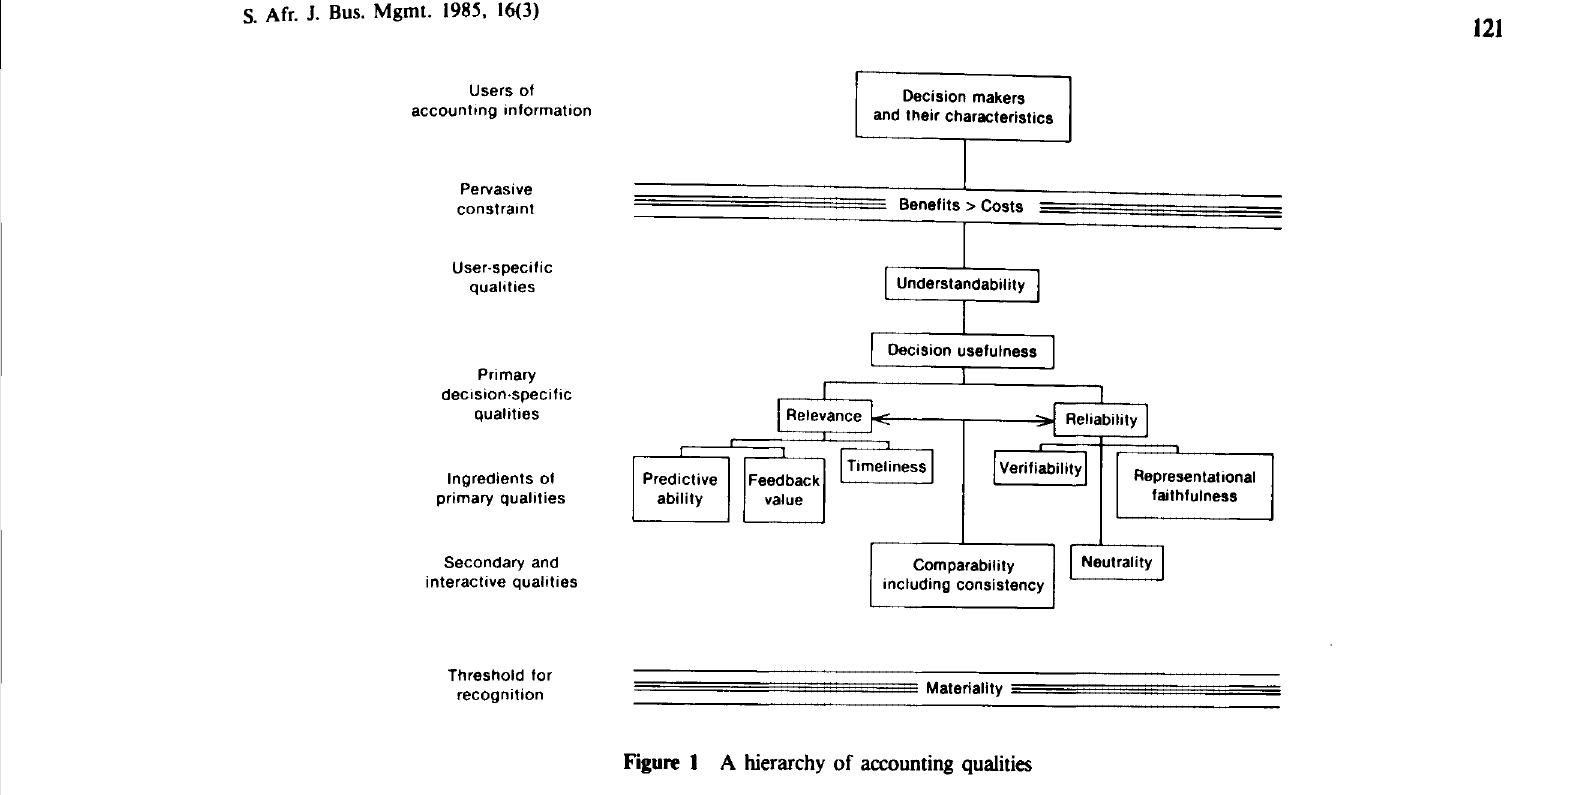
Figure 1 A hierarchy of accounting